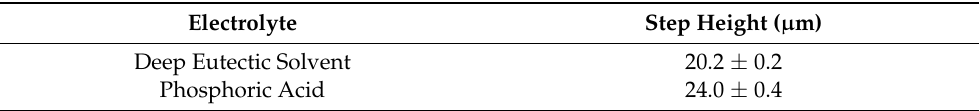
* All smoothing efficiency measurements reported as a % out of 100. Table 3. Average recorded step heights in µ m for five copper samples after treatment with the respective electrolytes listed at 70 ◦ C for 900